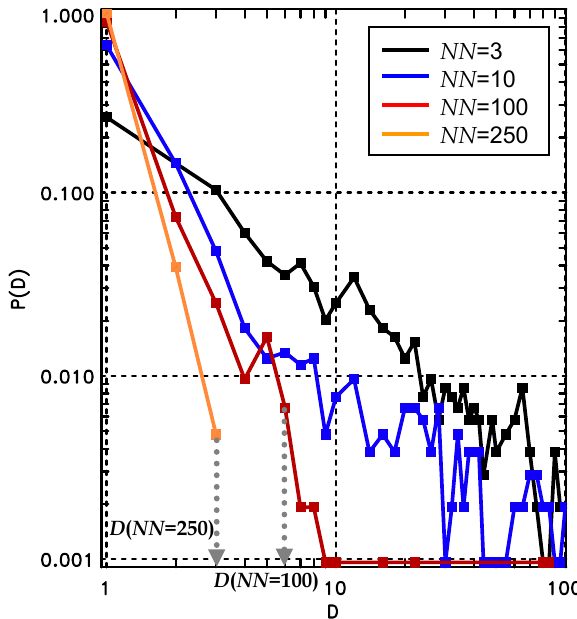
Fig. 7. Distribution functions of D n calculated with different values of NN for vB S − AL time series of Bargatze et al. (1985) database. For different NN the distribution function drops to zero at different values of D . The mean-field dimension decrease with the increase in the range of scale smoothed away after the